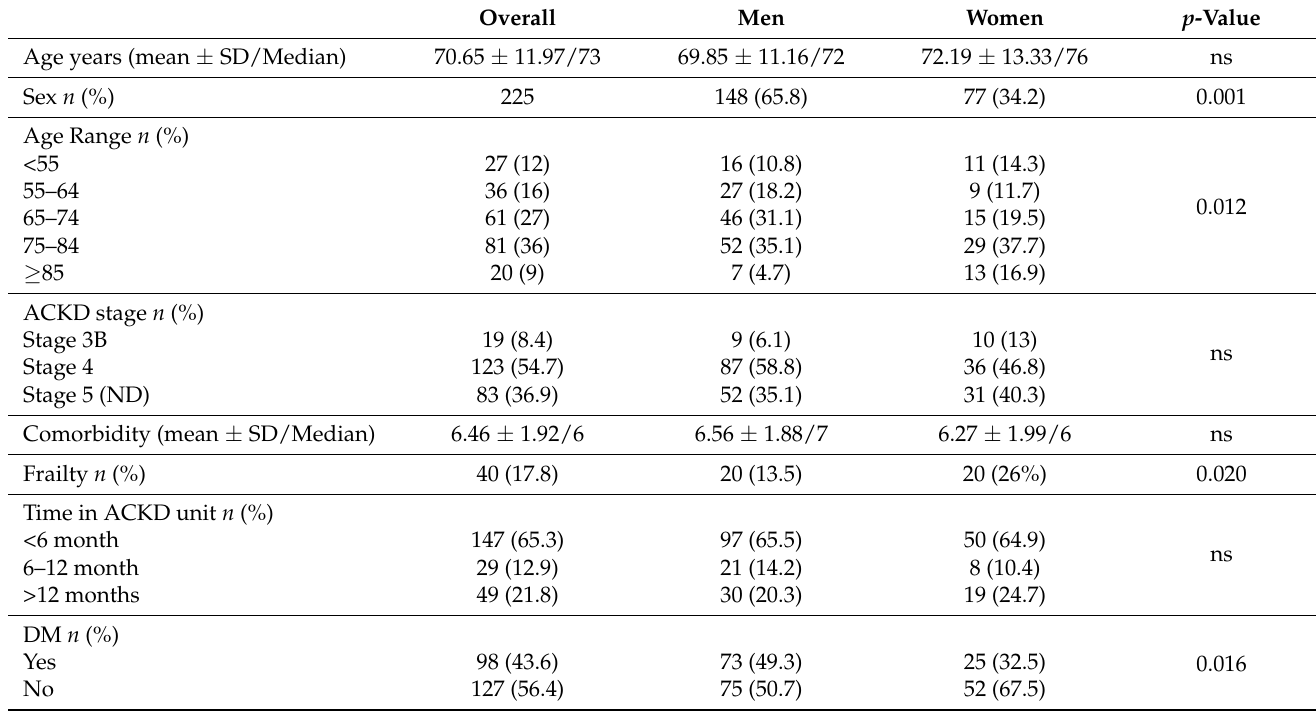
Table 1. General characteristics of the study